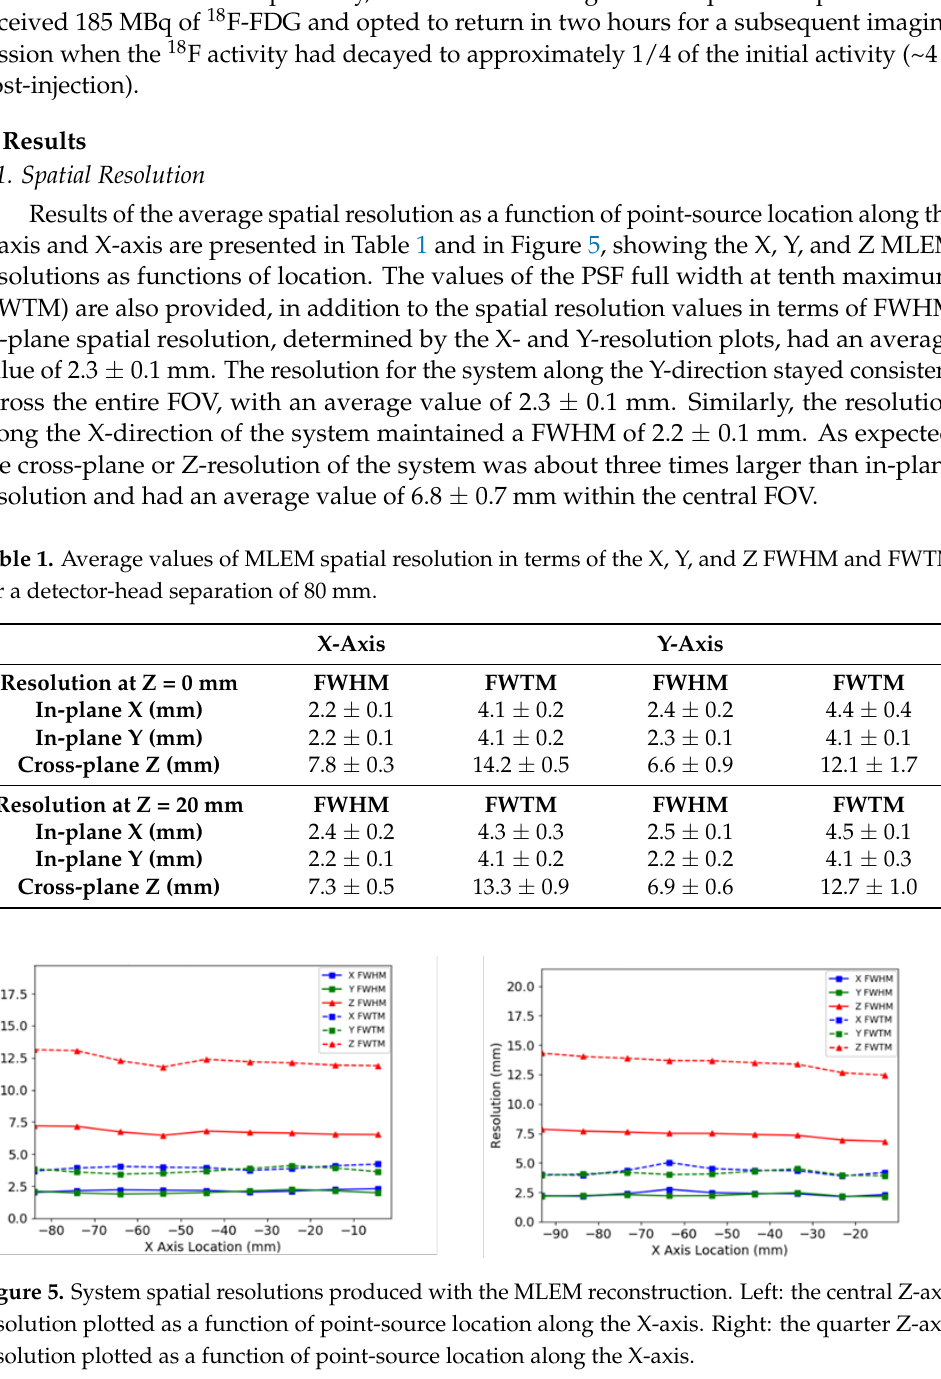
Figure 6. System spatial resolutions produced with a back-projection reconstruction. Left: the cen- tral Z-axis resolution plotted as a function of point-source location along the X-axis. Right: the quar- ter of the Z-axis resolution plotted as a function of point-source location along the X-axis. The reconstructed image of the micro hotspot phantom presented in Figure 7 demon- strates the visualization of small sources down to the 1.35 mm-diameter rods while using the MLEM reconstruction and down to the 1.7 mm-diameter rods with the back-projection reconstruction. As expected, MLEM-reconstructed images exhibited less noise and better image contrast.